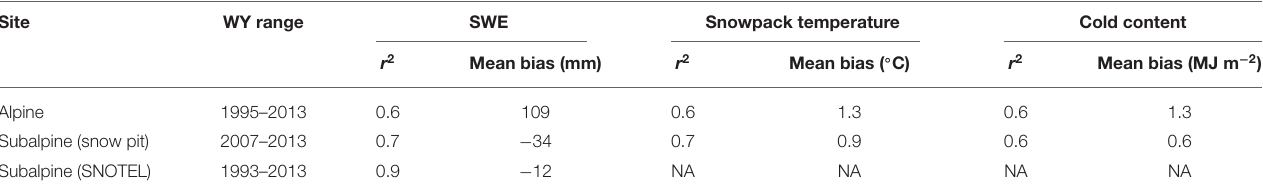
TABLE 2 | Validation metrics for the baseline simulations compared to snow pit SWE, depth-weighted temperature (T s ), and cold content data in the alpine and snow pit plus SNOTEL data in the